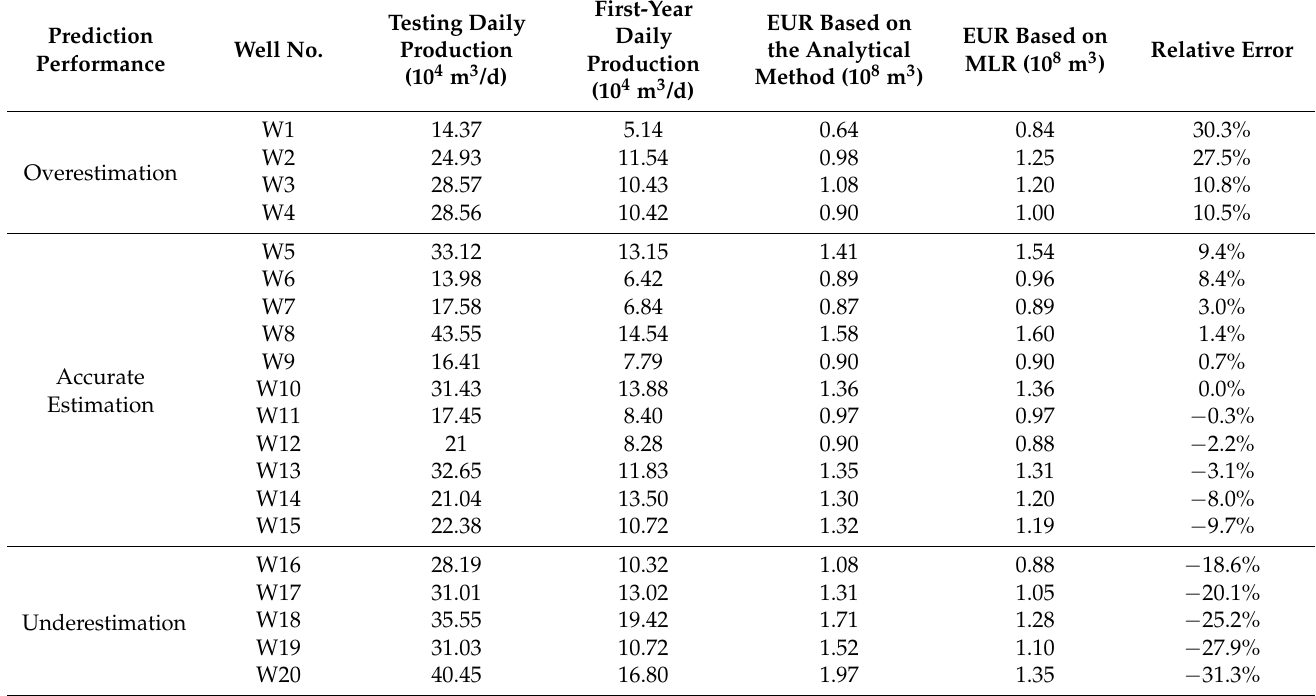
Table 6. Comparison of the results between MLR and the analytical